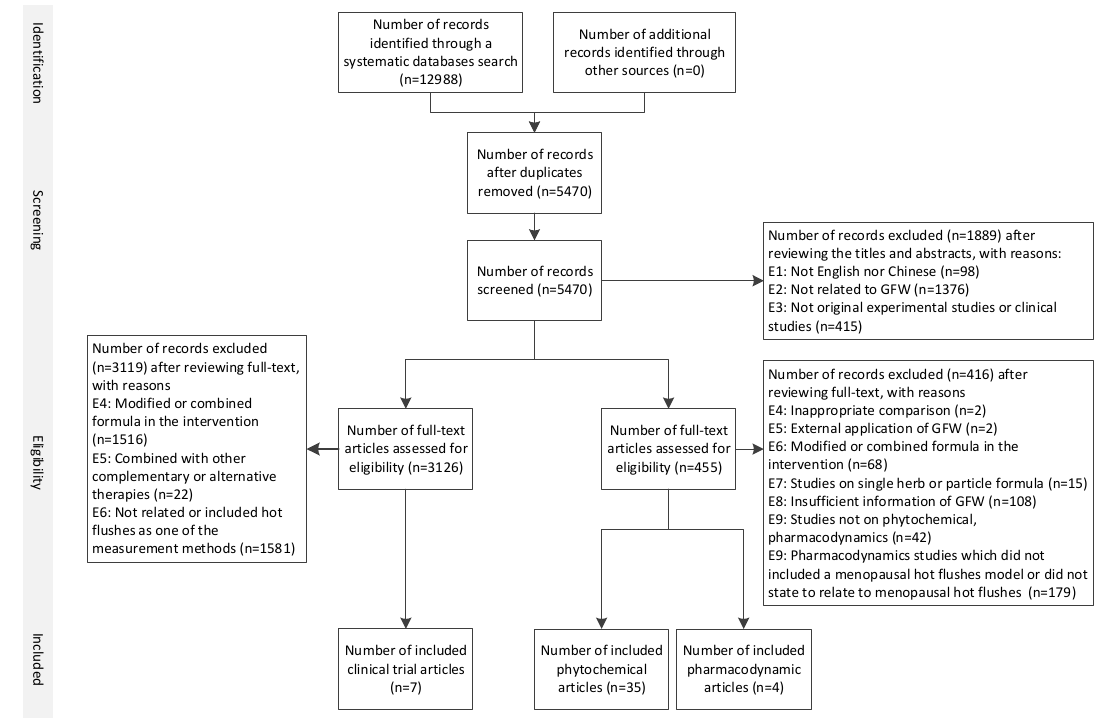
Figure 1. Flowchart of study selection procedures of Guizhi Fuling Wan on menopausal hot flushes.